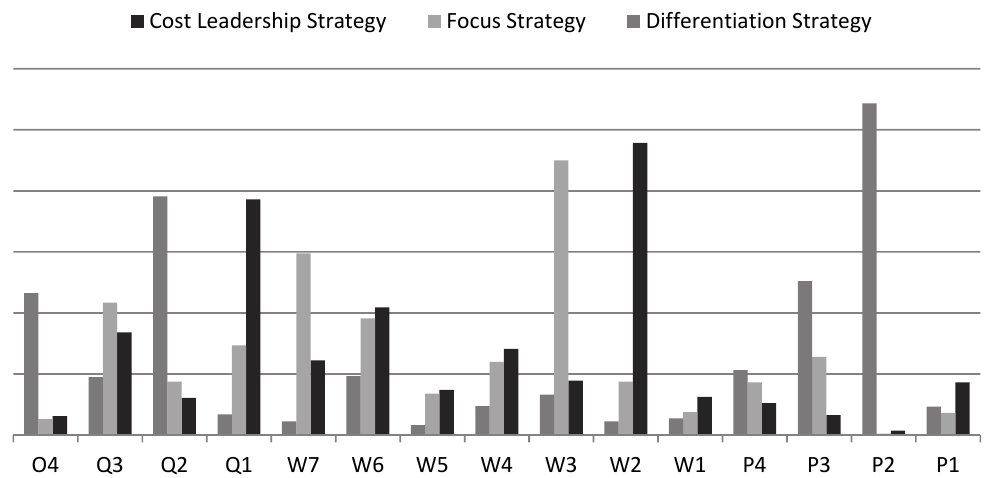
Fig. 8. Comparison of weights for sub-factors in different strategies